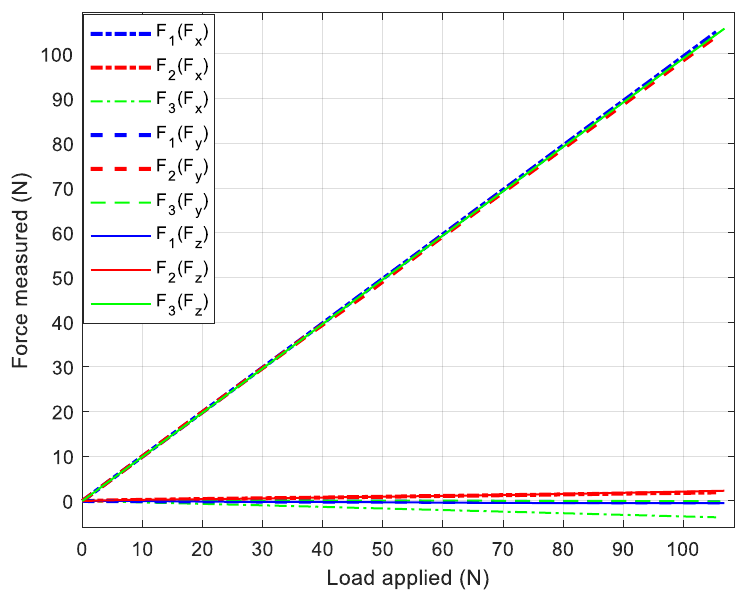
Figure 4. Calibration plot for system with locknut collars.